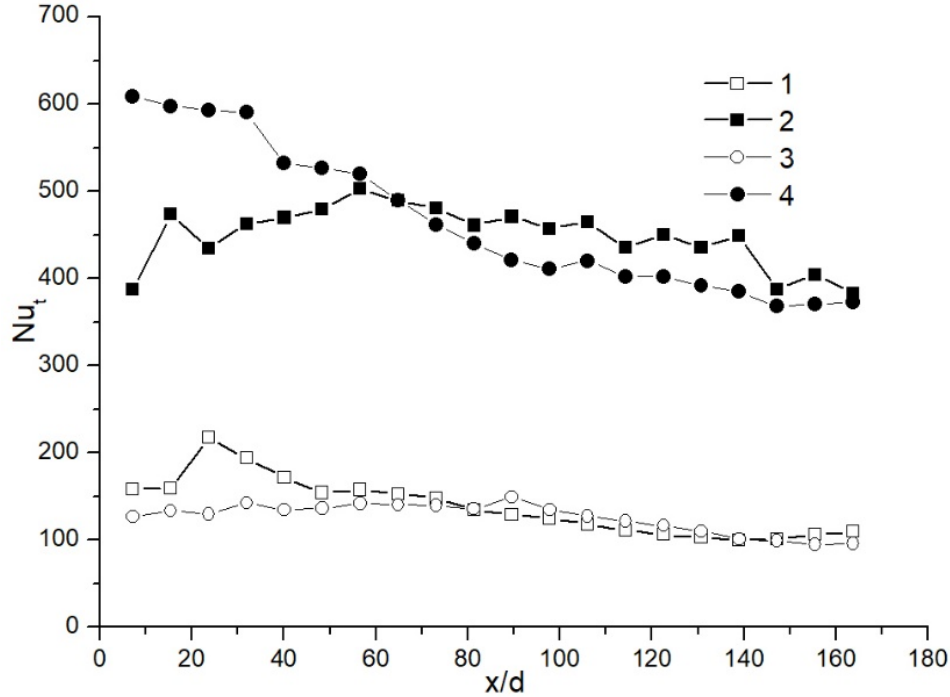
Figure 3. Distribution of the total local Nusselt number along the model of the condensing heat exchanger at Re in ≈ 9500, different flue gas inlet temperatures and for the cases when no water was injected into the flue gas flow and when it was injected: (1) t in ≈ 80 °C without injection, (2) t in ≈ 87 °C with injection, (3) t in ≈ 115 °C without injection, (4) t in ≈ 122 °C with injection.